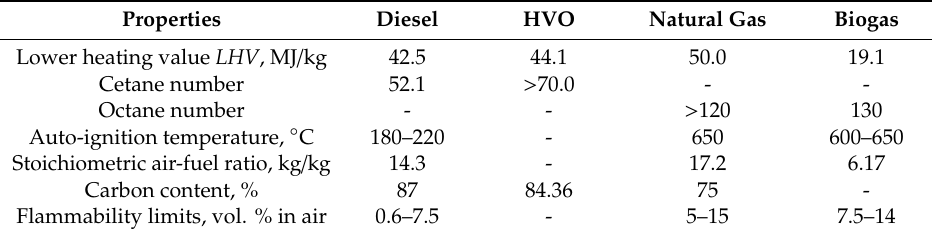
Table 1. Main characteristics of the fuels.